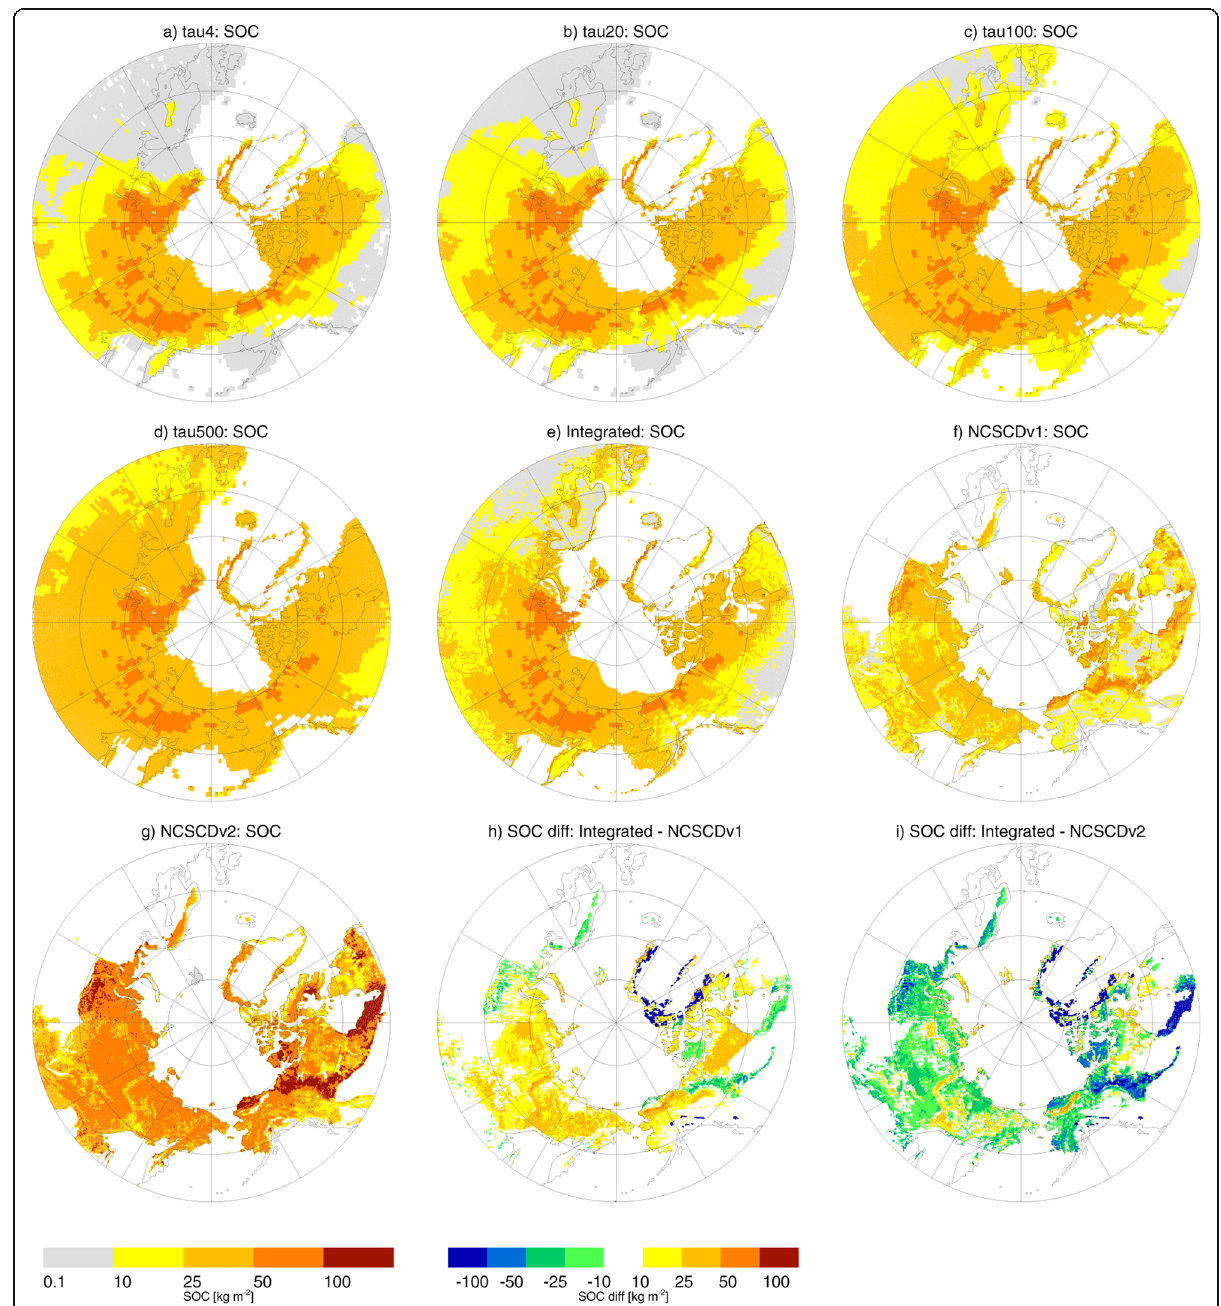
Fig. 5 Present-day circum-Arctic SOC distribution. The simulated distribution of SOC for the circum-Arctic region north of 50° N at 1° resolution for a τ = 4, b τ = 20, c τ = 100, and d τ = 500. e The integrated SOC map at 0.2° resolution. Observation-based map for f the NCSCDv1 and g NCSCDv2 datasets. Difference maps between the integrated map and h the NCSCDv1 and i NCSCDv2 datasets. The common color bar for a to g is shown under g , and that for h and i is shown under